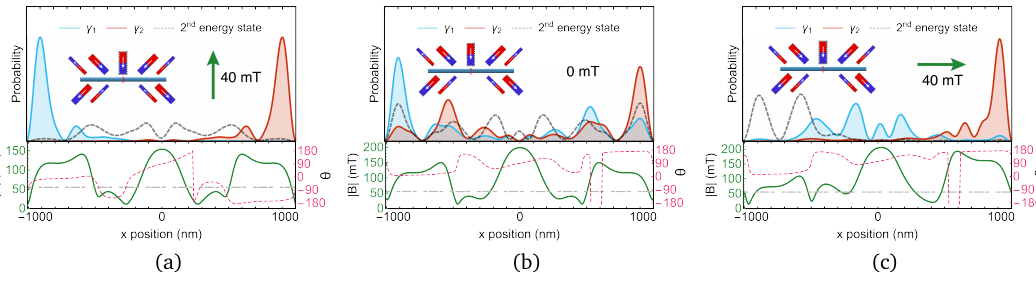
Figure 9: Comparing the double Dragonfly with different external fields. (a) 40 mT in the positive y direction (b) no field and (c) 40 mT in the positive x